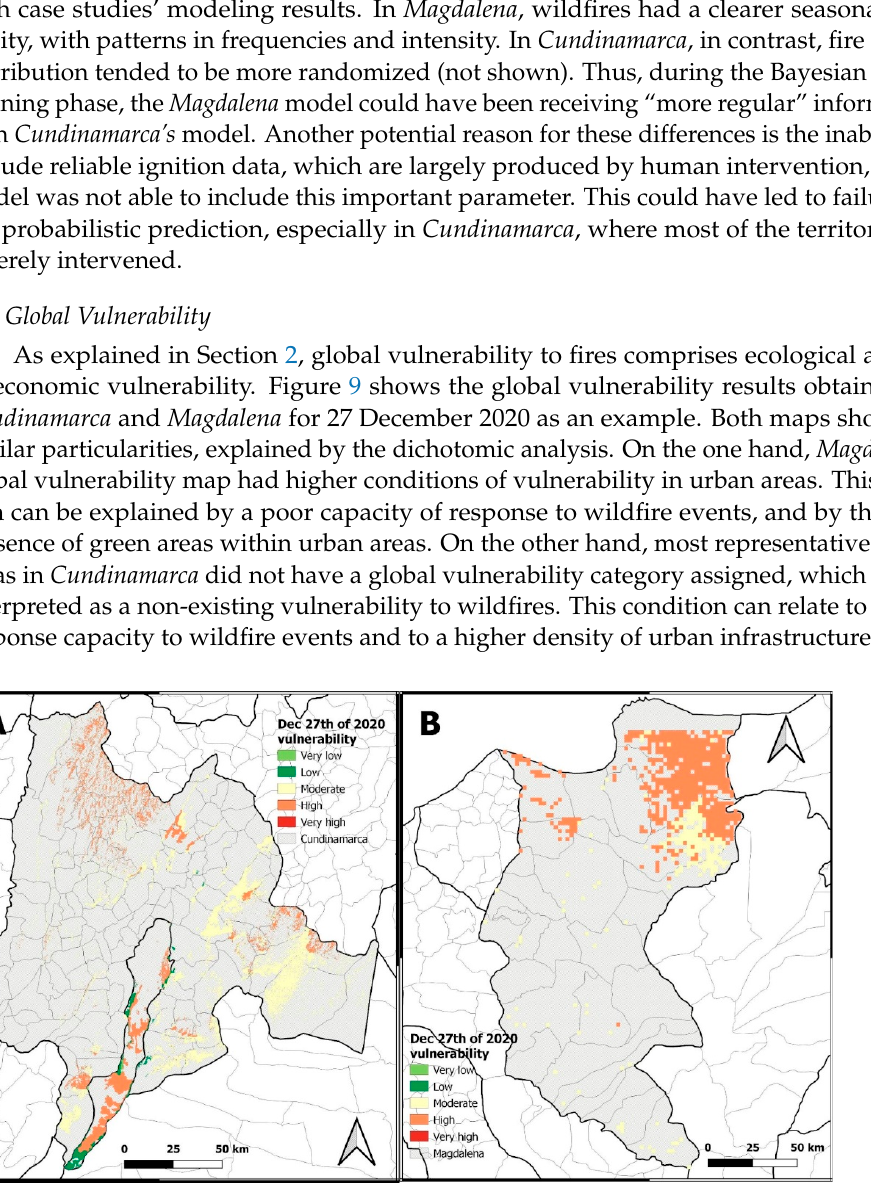
Figure 9. Global vulnerability of Cundinamarca ( A ) and Magdalena ( B ). Colors represent the global vulnerability category as very high (red), high (orange), moderate (yellow), low (green), very low (light green).